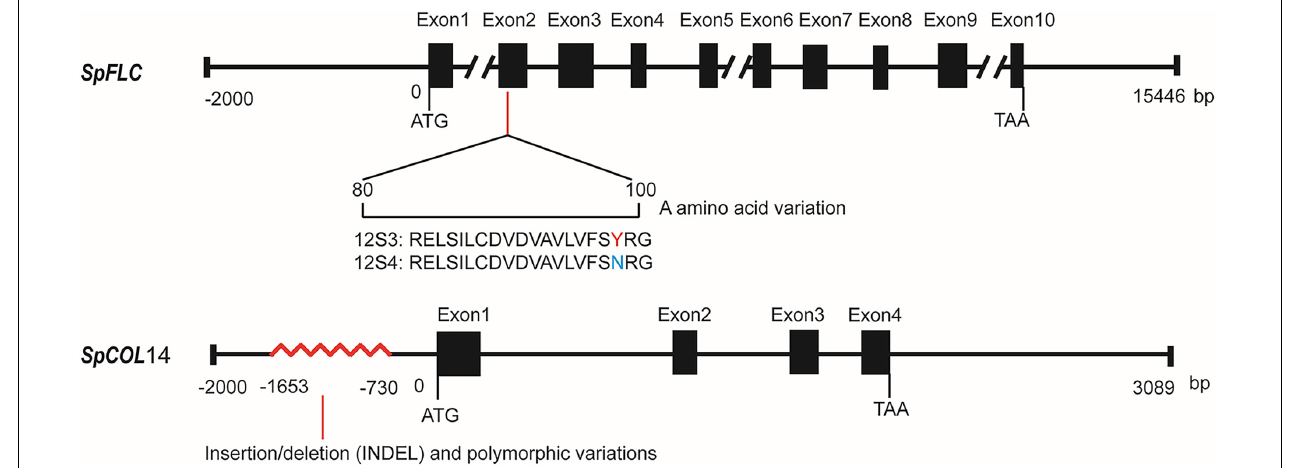
FIGURE 6 | A schematic of the variations in SpFLC and SpCOL 14 between the two